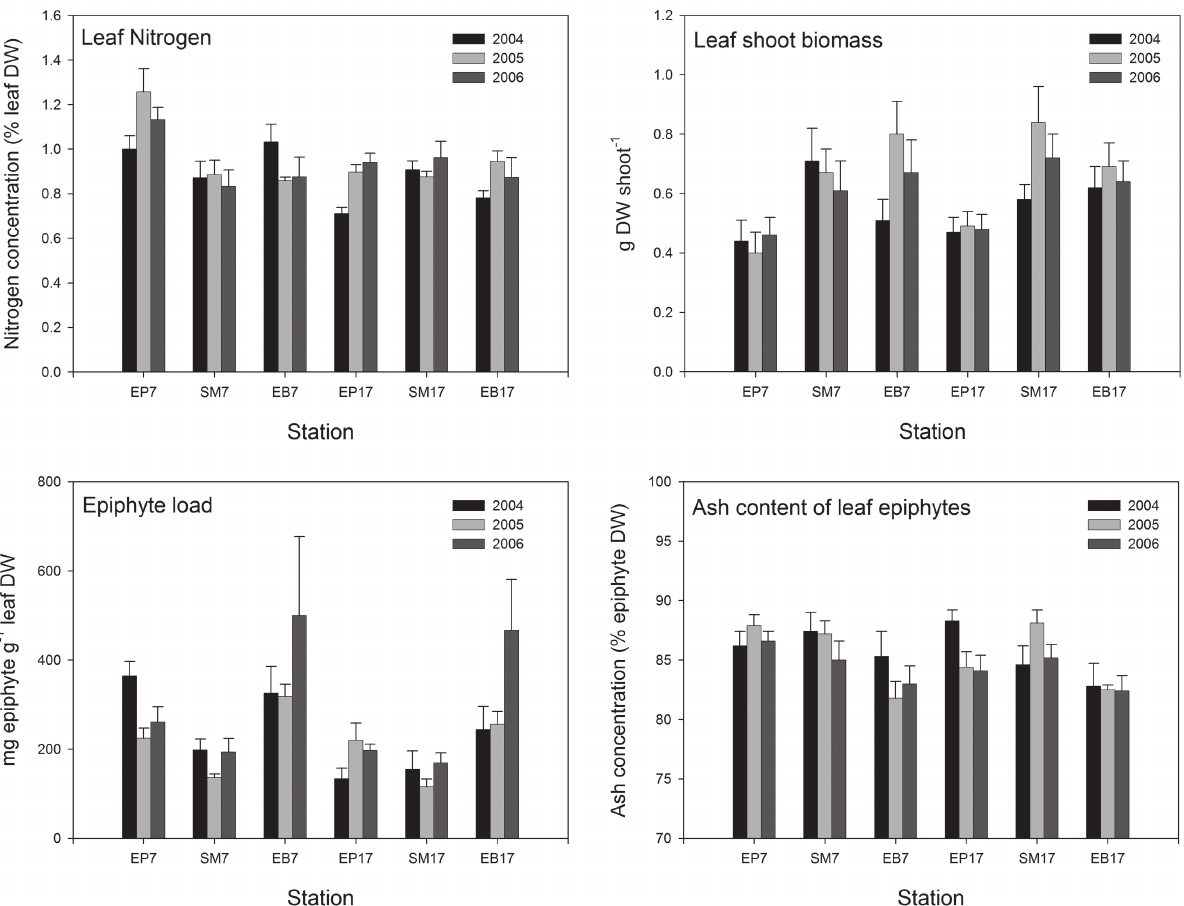
Fig . 2. – concentration of nitrogen in the leaves (as percentage of leaf dry weight, dW), leaf shoot biomass (g dW shoot -1 ), epiphyte load (mg epiphyte dW g -1 leaf dW), and the ash content of leaf epiphytes (as percentage of epiphyte dW) of Posidonia oceanica at three sites (eP: es Port; sM: cala santa María; eB: es Burri), two depths (7 m, 17 m) in each site, and three years (2004, 2005, 2006) in cabrera archipelago national Park (Balearic islands, Western Mediterranean). error bars represent